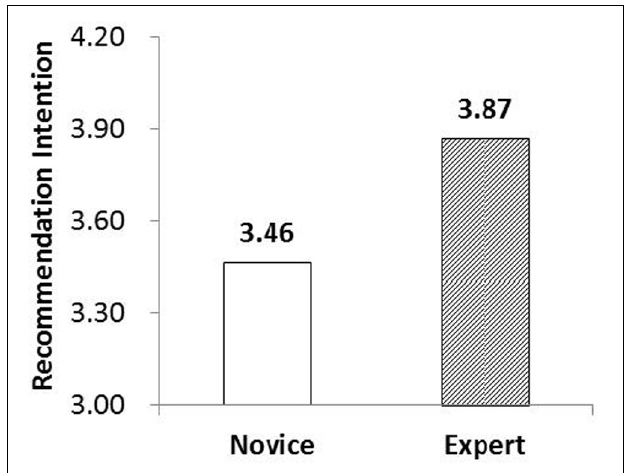
FIGURE 4 | Main effect of customer knowledge on WOM intentions.